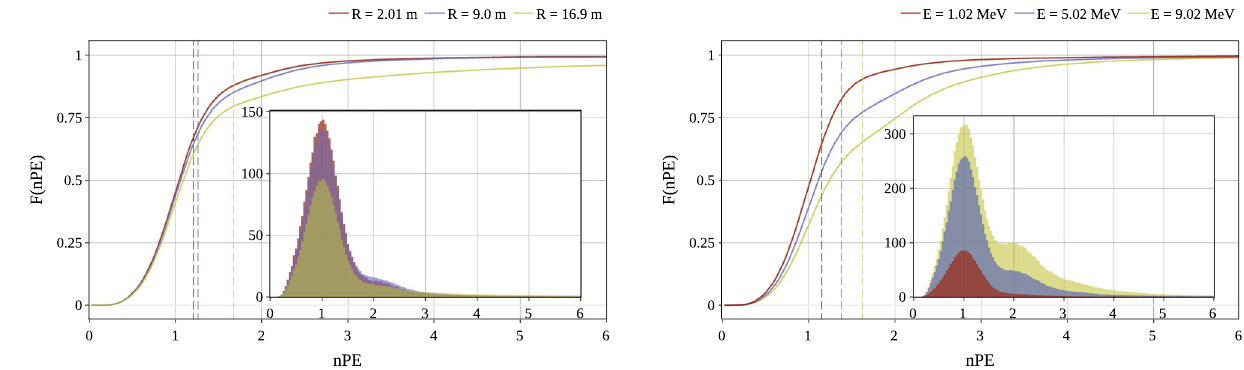
Fig. 4 Examples of CDFs and PDFs for charge distributions for events with the kinetic energy of E kin = 1 MeV but different radius (left) and events at the center of the detector ( R = 0) but different energies (right). Dashed lines denote PDF mean values